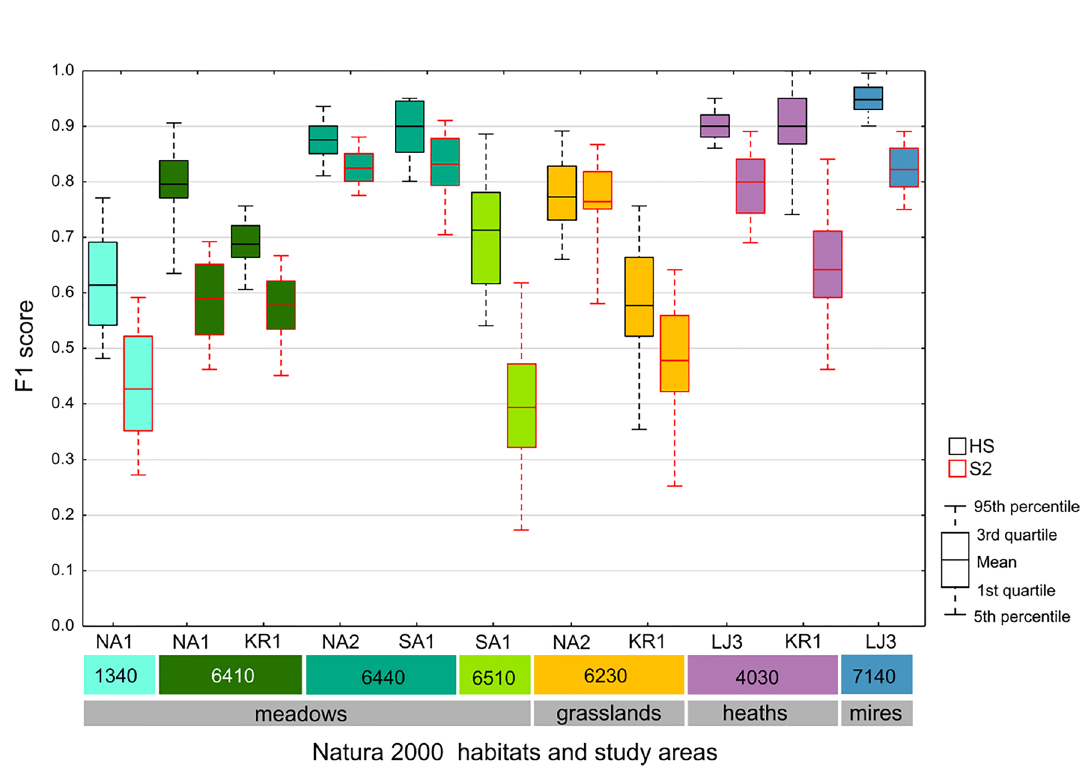
Figure 6. The distribution of F1 accuracy values for each Natura 2000 habitat. The F1 value was acquired from confusion matrices calculated based on fifty cal/val polygons stratified random sampling (Table 2). Figure created by the authors using RAWGraphs 2.0 beta (https:// app. rawgr aphs.